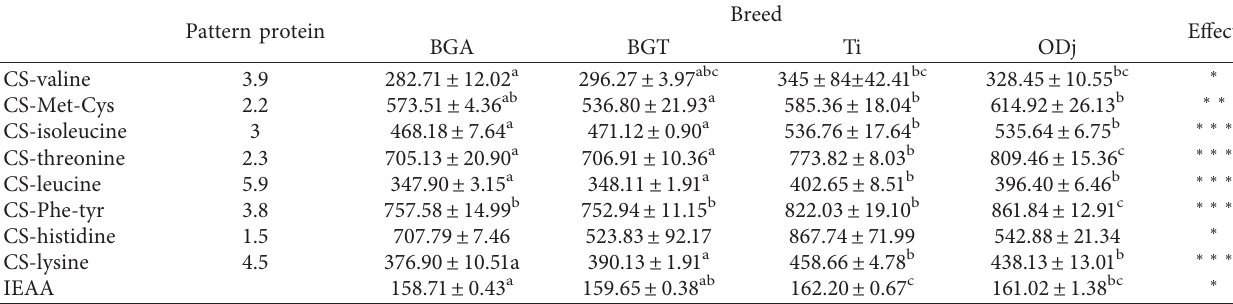
Table 5: Protein quality index (CS and IEAA) of Beni-Guil, Timahdite and Ouled-Djellal sheep meats. Pattern